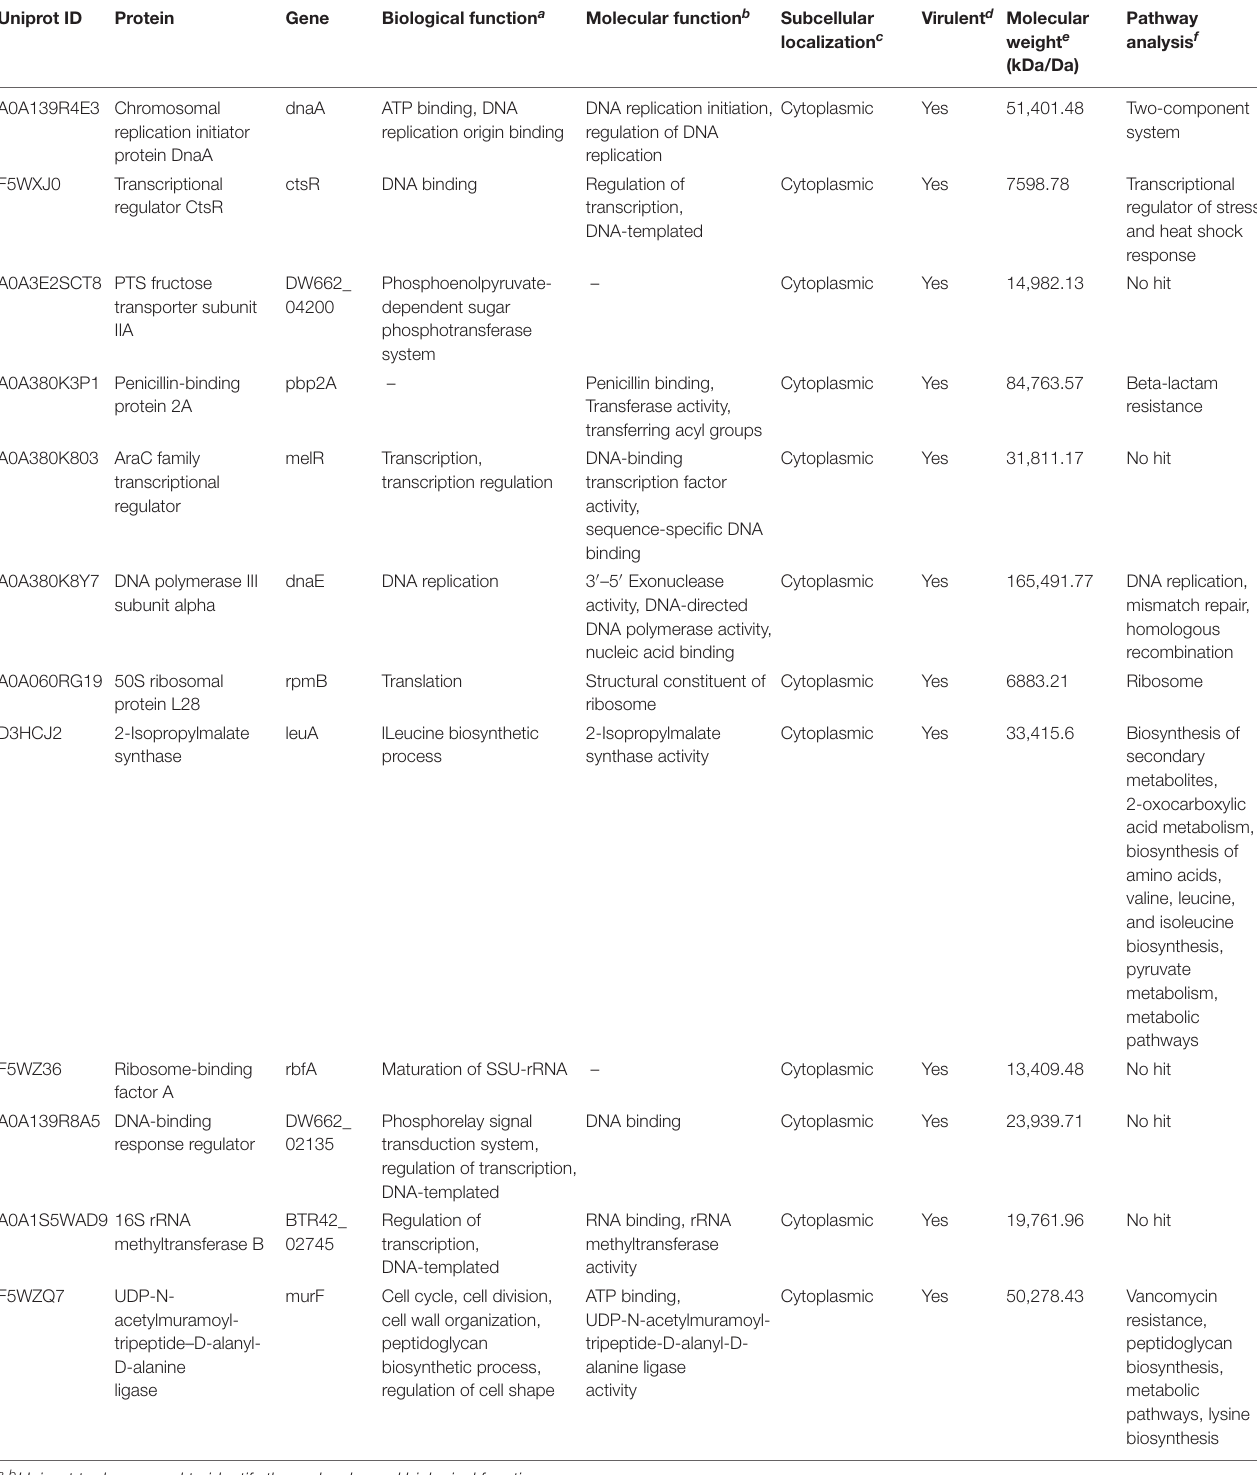
TABLE 3 | Drug and vaccine target prioritization parameters and functional annotation of 12 essential non-host homologous proteins. Uniprot ID Protein Gene Biological function a Molecular function b